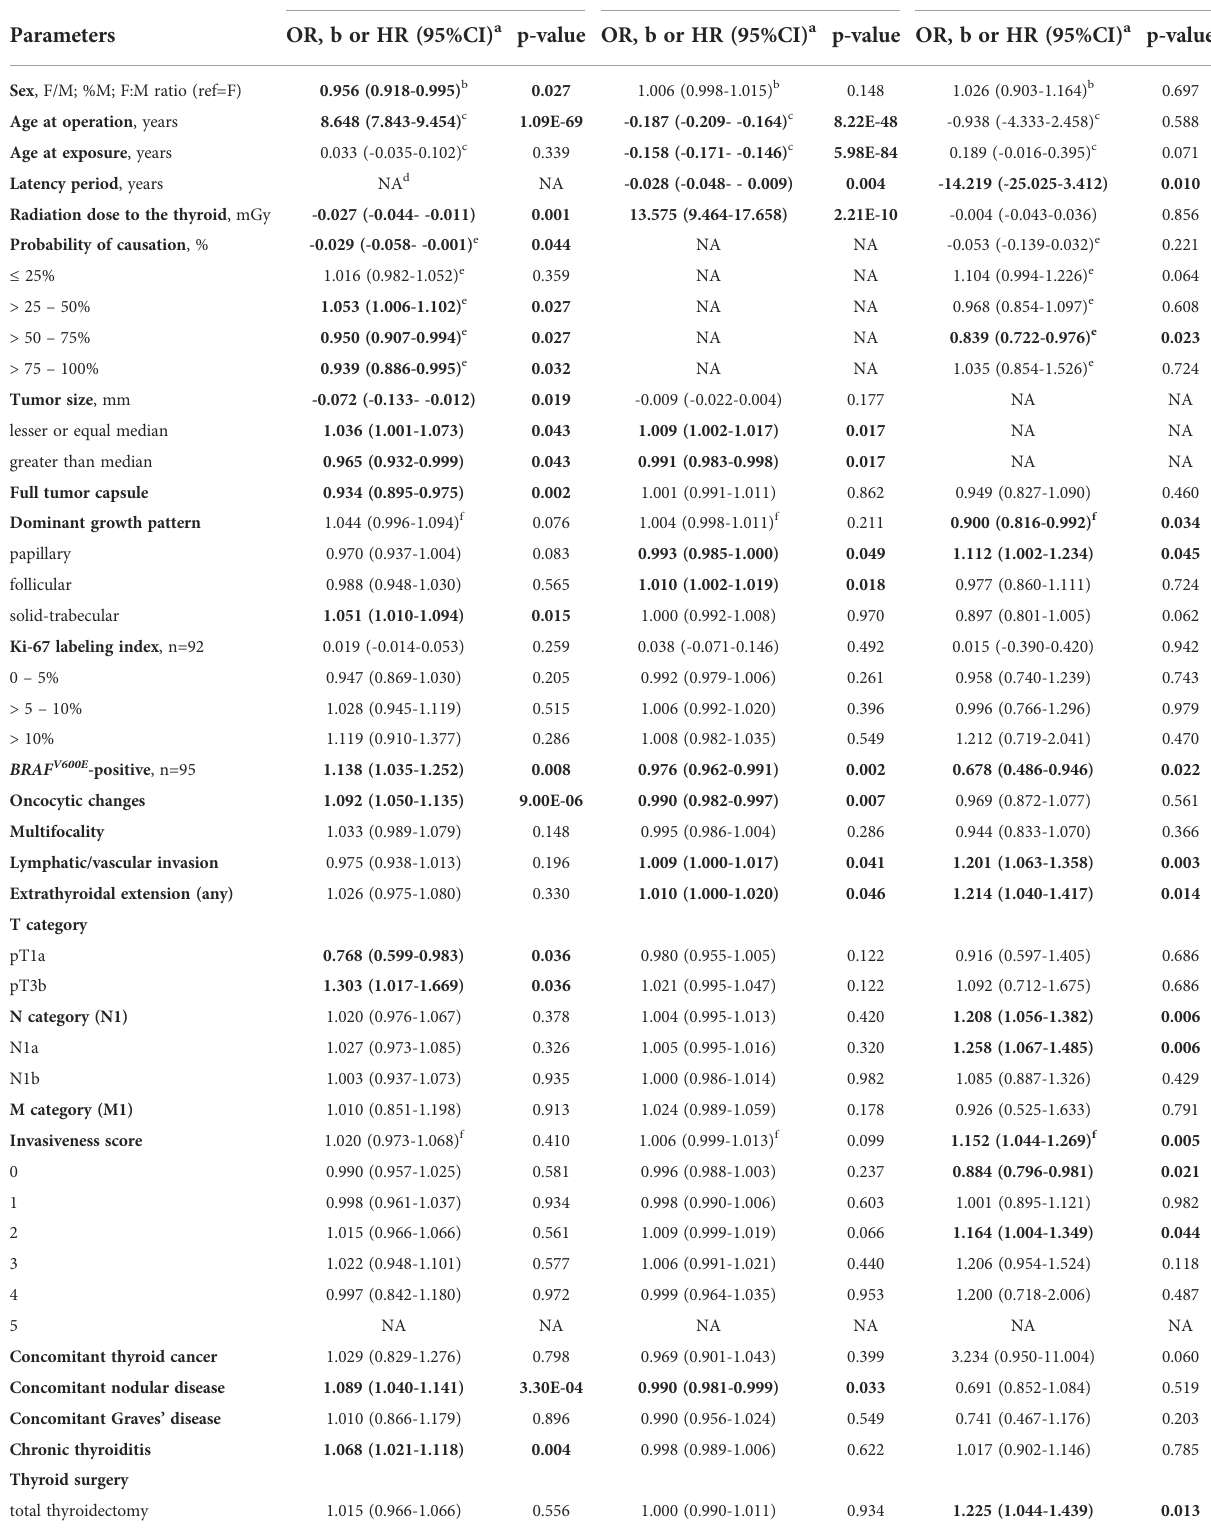
TABLE 2 Associations of radiogenic MPTCs with the latency period, probability of causation due to radiation, and tumor